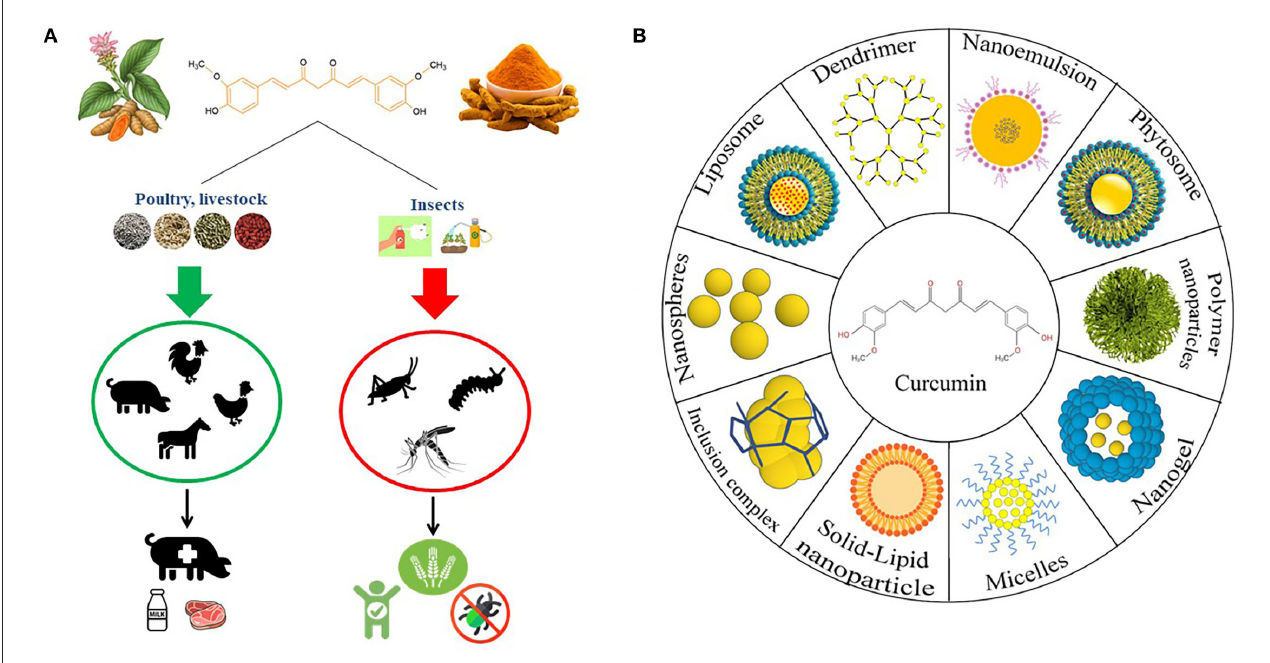
FIGURE1 (A) Curcumin effects on livestock, poultry and insects when supplemented or used as a feed additive and insecticides. (B) The different types of curcumin